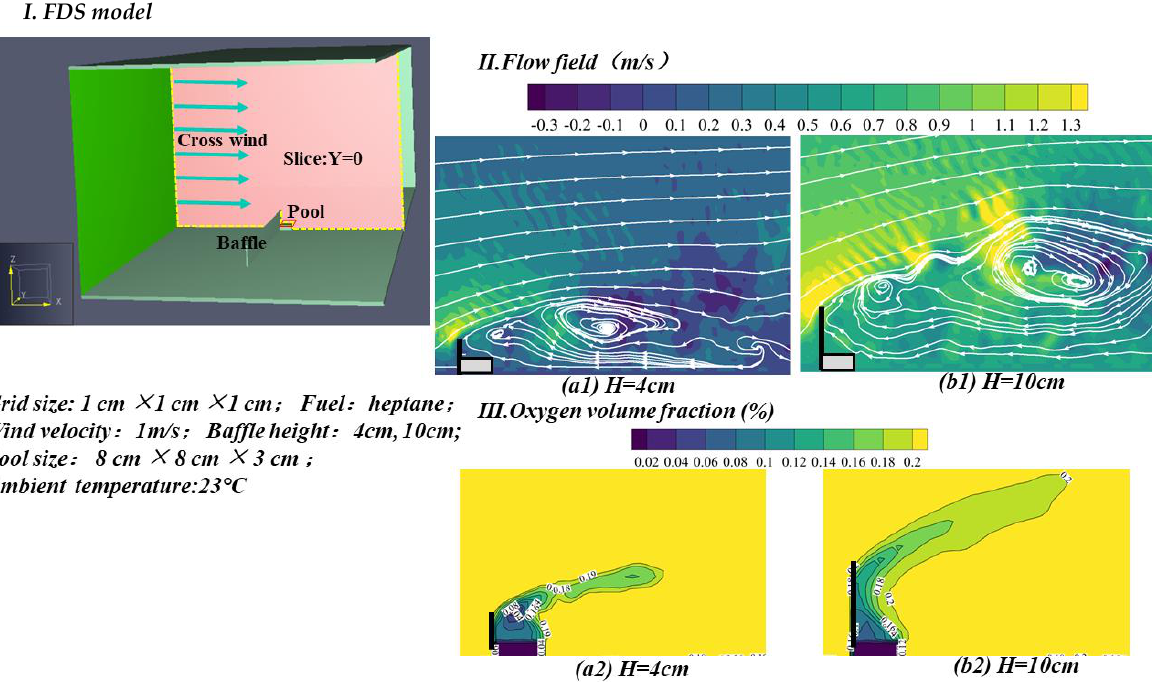
Figure 4. FDS model configuration and simulation results of the flow field and oxygen volume fraction.